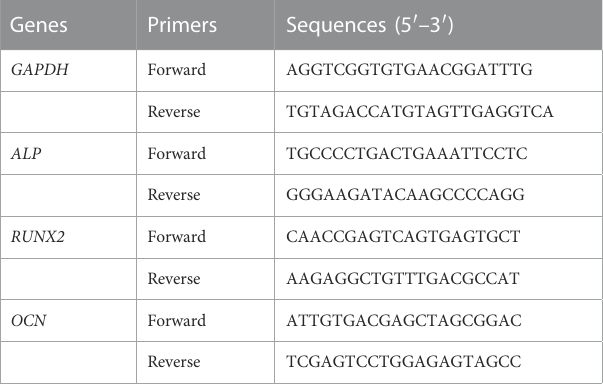
TABLE 1 Sense and antisense primers for real-time reverse transcription PCR. Genes Primers Sequences (5 ′ – 3 ′